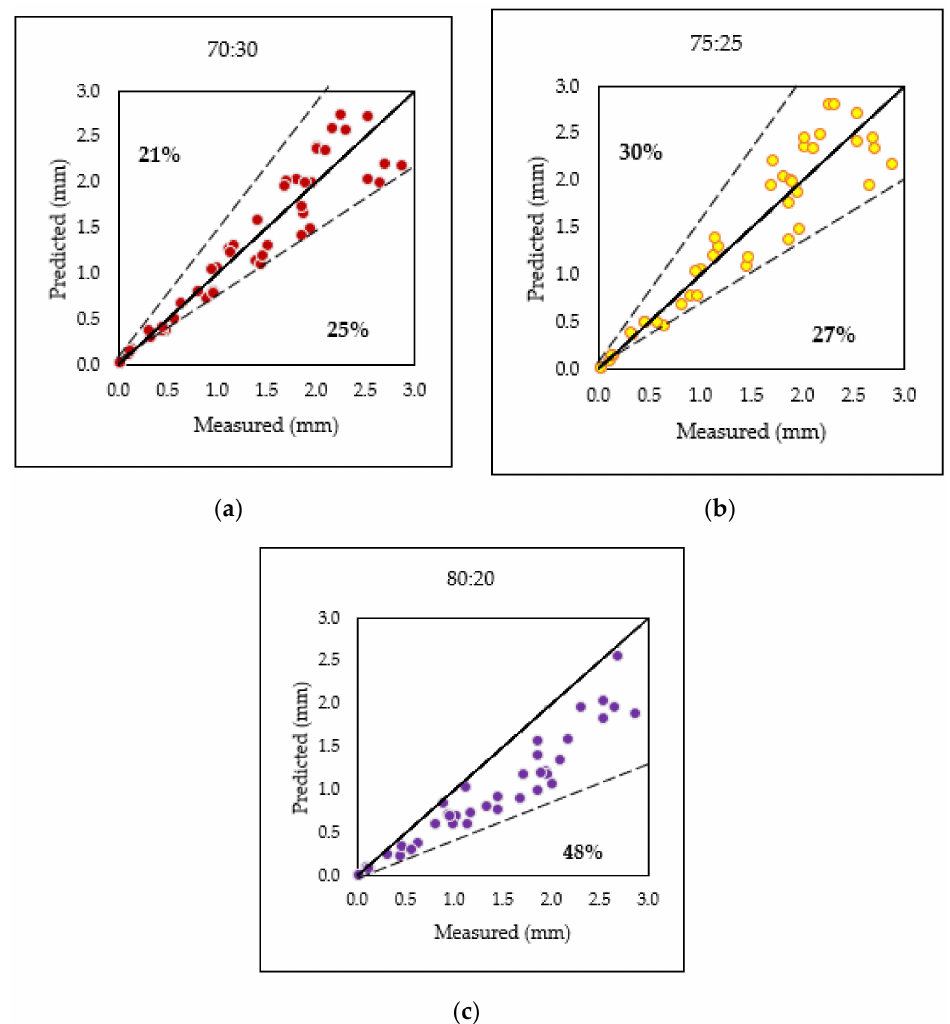
Figure 11. The distribution of predicted results according to every split ratio ( a ) 70:30, ( b ) 75:25, and ( c )